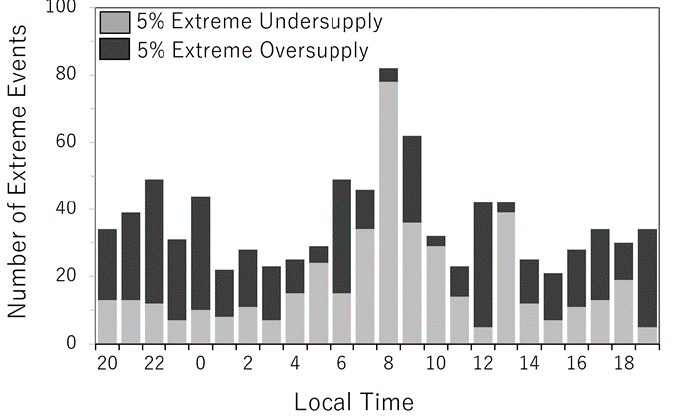
Figure 12. The annual number of occurrences of the 5% most extreme undersupply events (grey bars) and oversupply events (black bars) of wind speeds for each hour of a day.